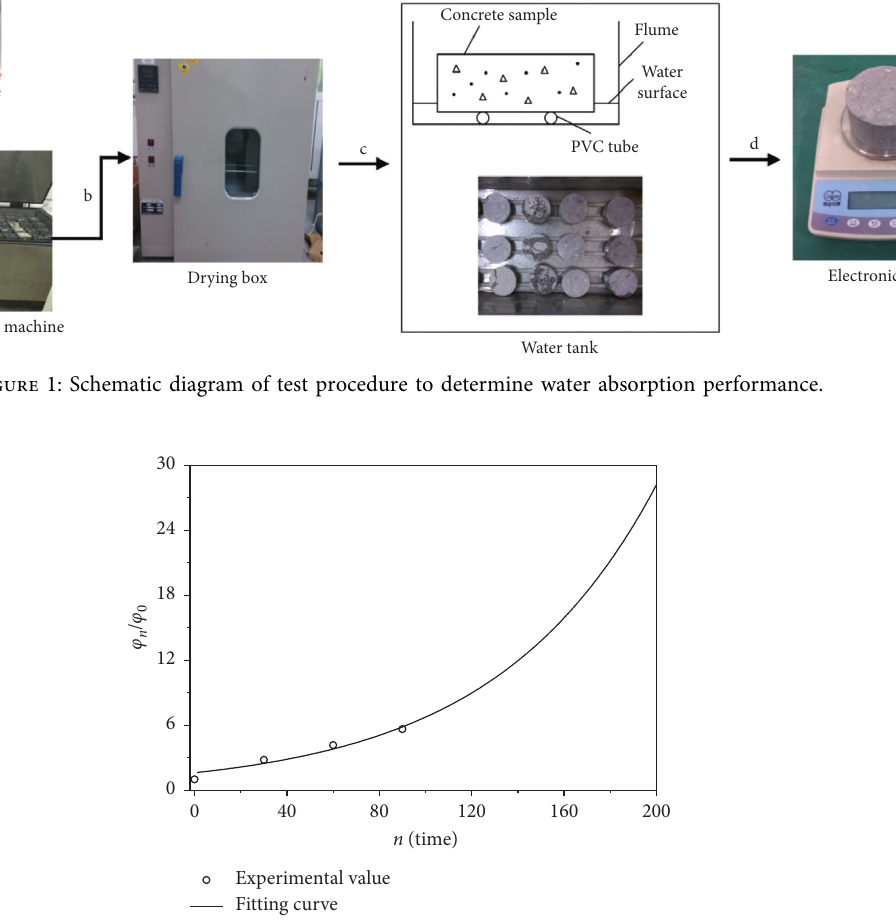
Figure 2: Porosity ratio ( ϕ